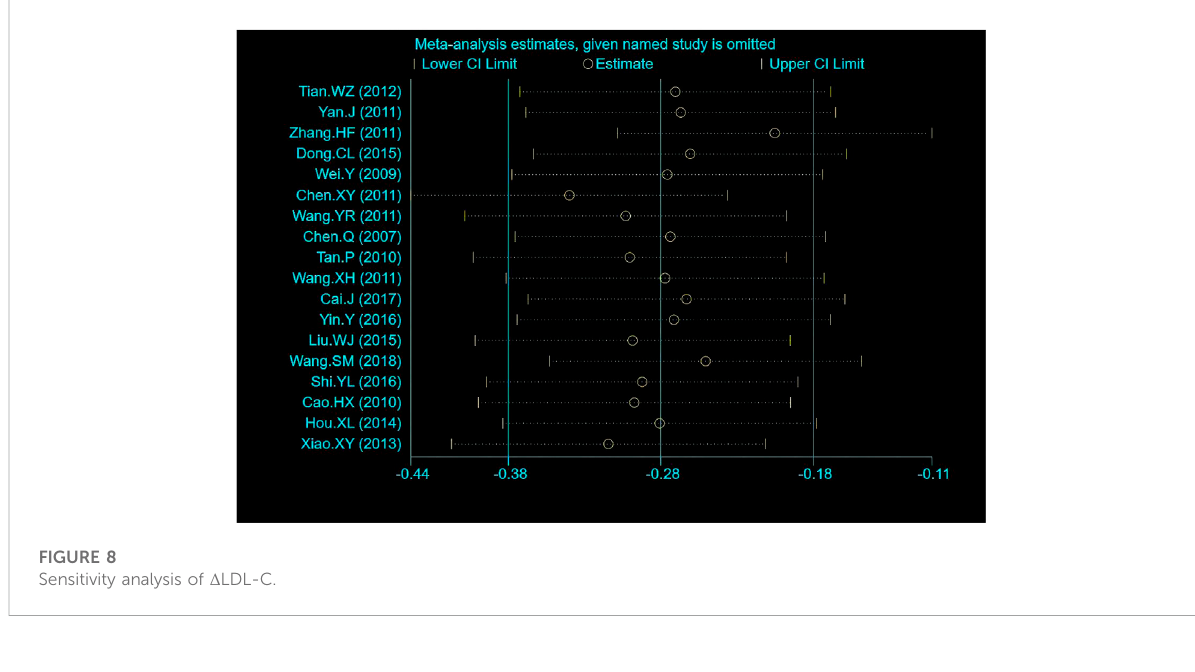
TABLE 6 Meta-regression of